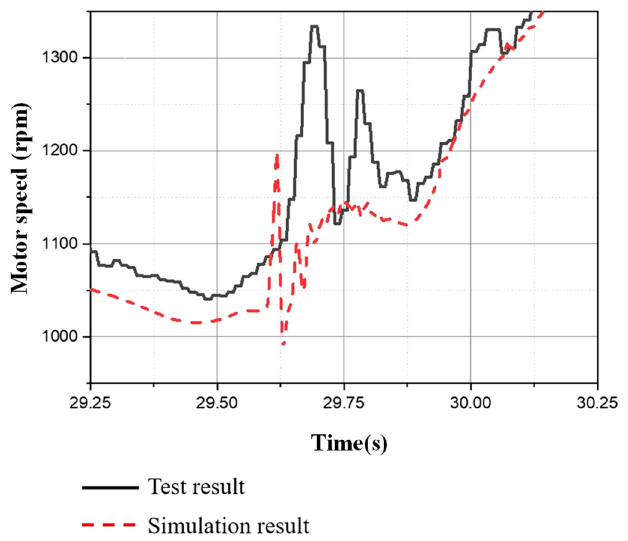
Figure 9. Contrast between the simulated motor speed and the measured speed under a single tip- in